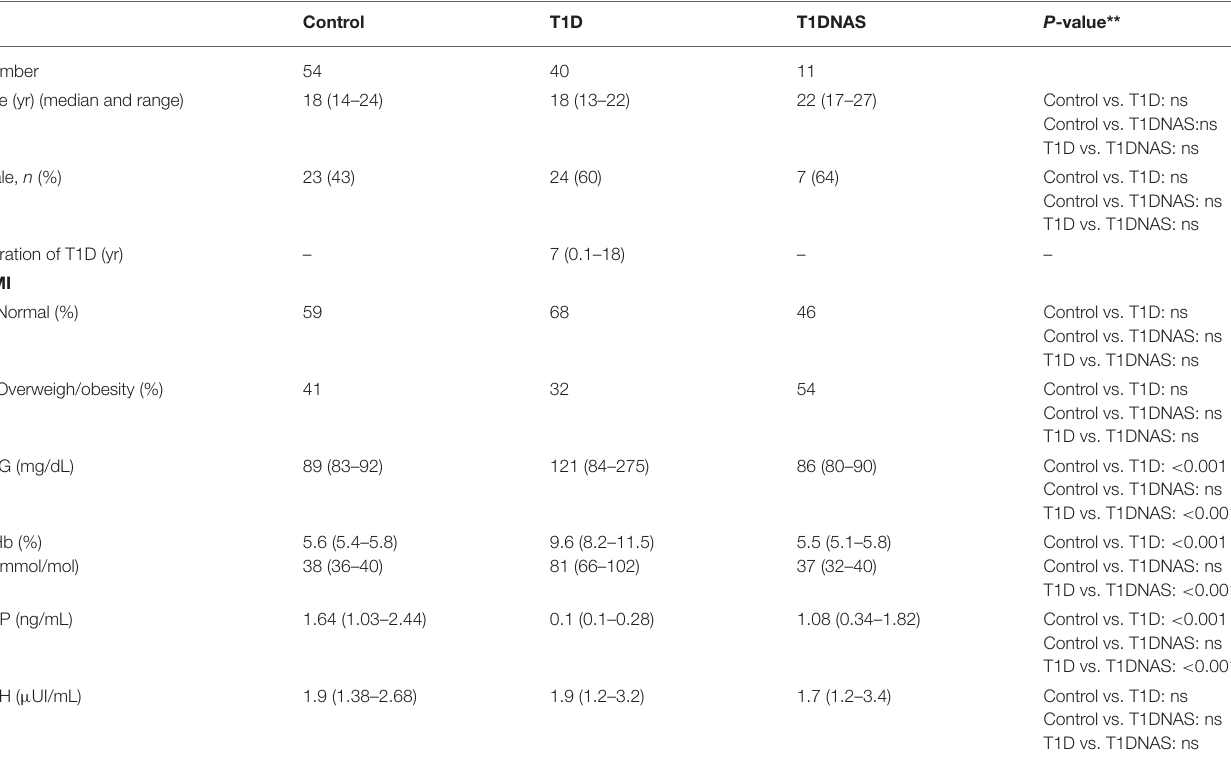
TABLE 1 | Clinical, metabolic and endocrine characterization of control subjects, type 1 diabetes (T1D) patients from multiplex families and their non-affected siblings (T1DNAS) studied. Control T1D